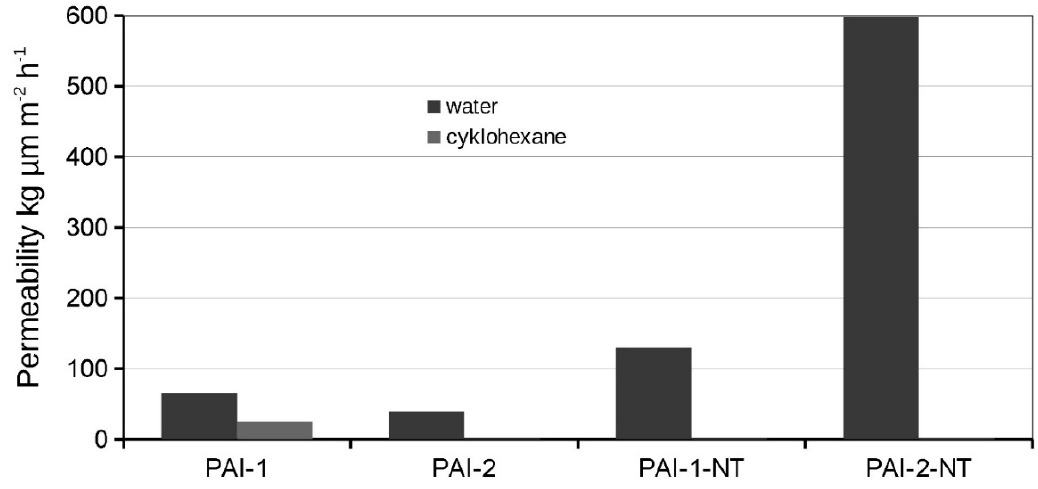
Figure 26. Permeability by water and cyclohexane (at 40 °C) of non-porous membranes PAI-1, PAI-1-NT, PAI-2, and PAI-2-NT